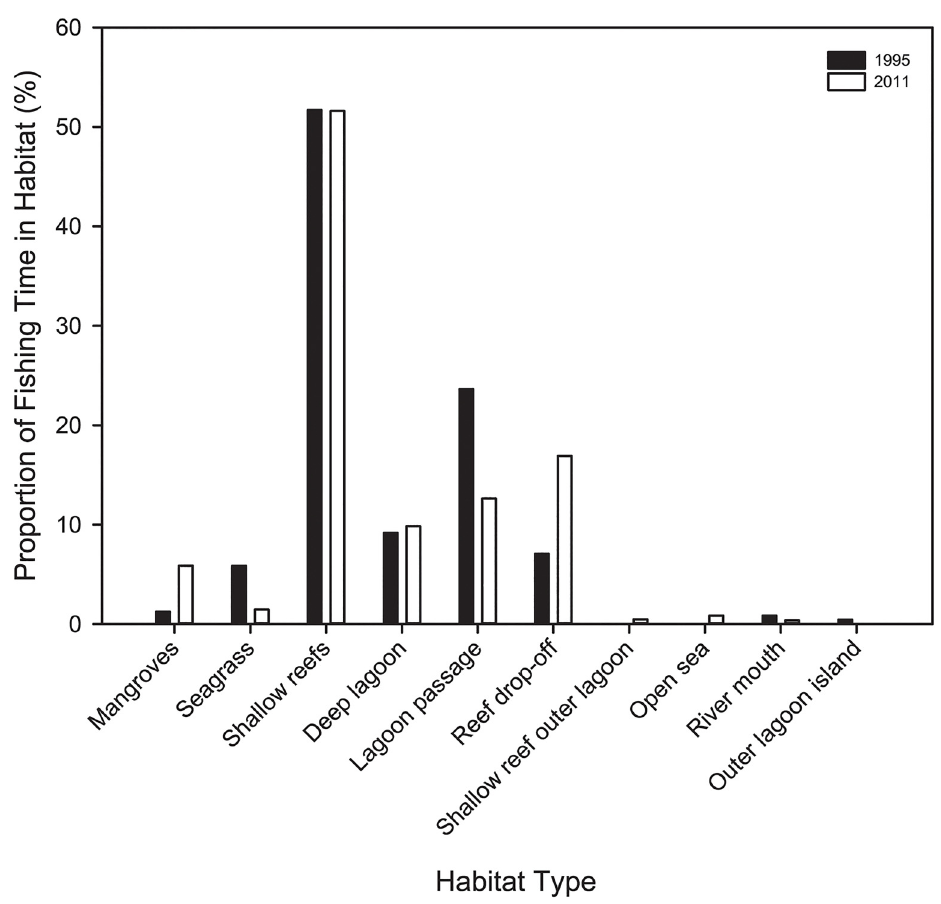
S1 Fig. Map of Solomon Islands and study location. S1 Table. Statistical results of Kruskal-Wallis analysis by fishing